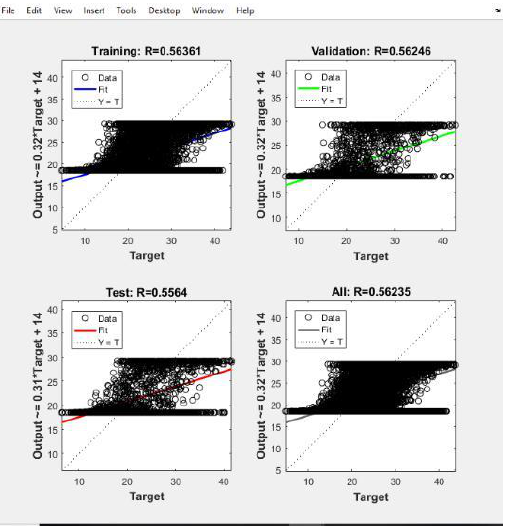
Figure 31 . The three plots represent the training, validation, and testing data. The dashed line in each plot represents the perfect result – outputs = targets. The solid line represents the best fit linear regression line between outputs and targets. The R value is an indication of the relationship between the outputs and targets. If R = 1, this indicates that there is an exact linear relationship between outputs and targets. If R is close to zero, then there is no linear relationship between outputs and targets. Table 1 . Number of Iteration and Epochs will lesser the Gradient value means the train set is almost near to